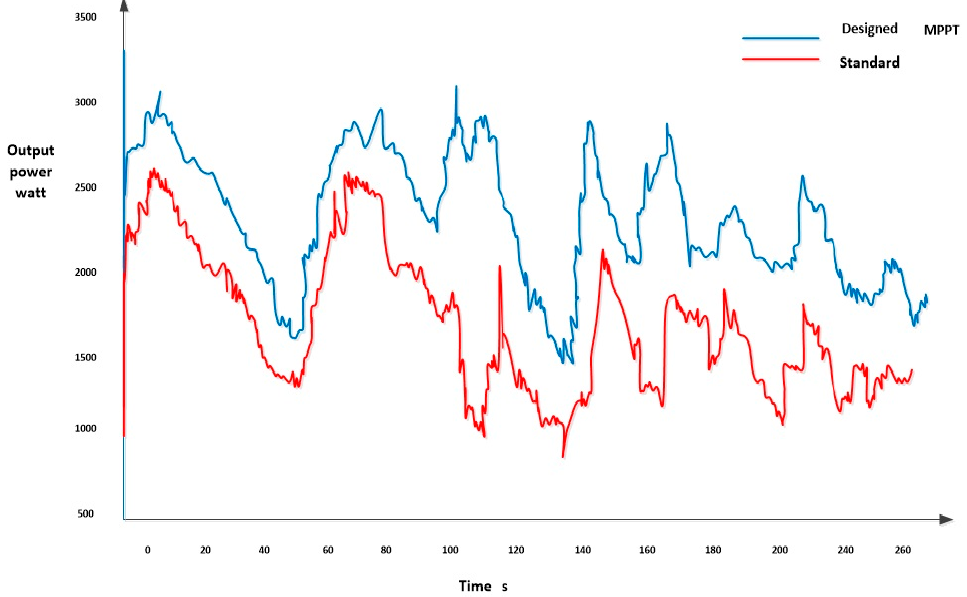
Figure 17. The difference between DFIG output power in both standard and designed Eco-MPPT cases. Table 2. MATLAB execution time for different techniques.